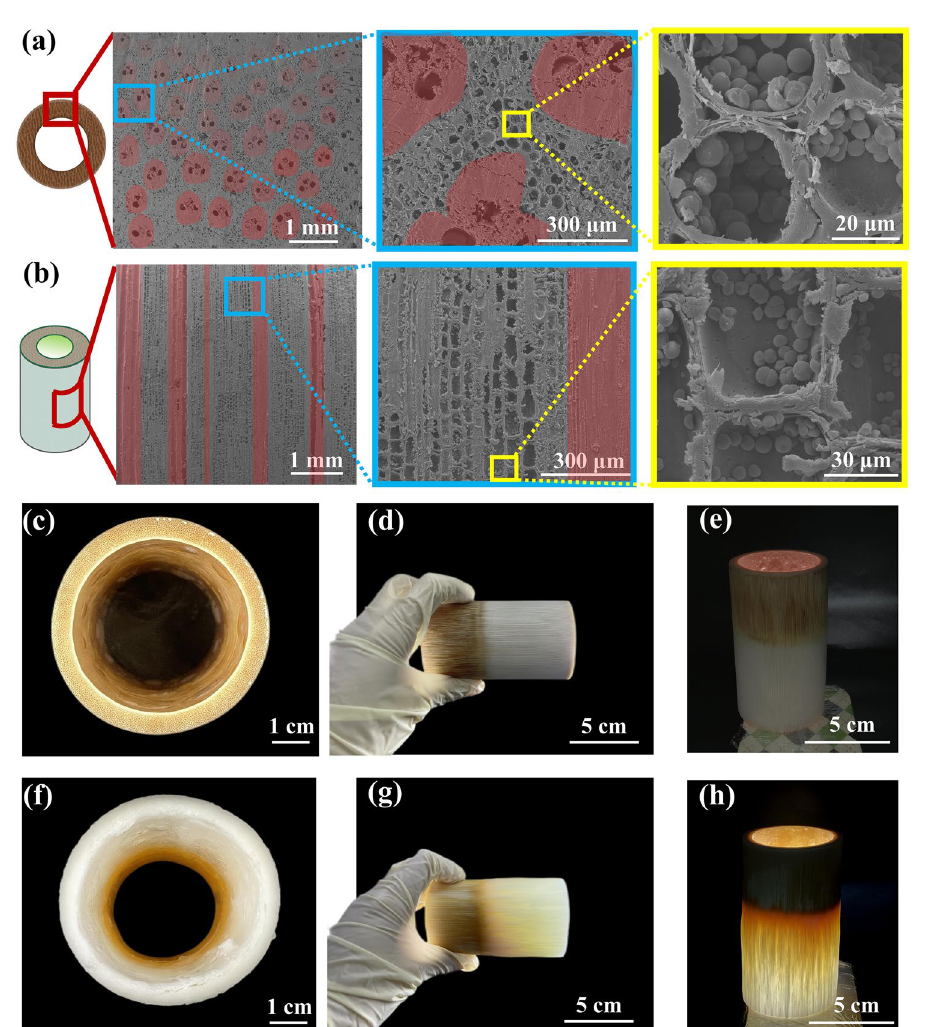
Fig. 2 a Cross-sectional SEM images of OB. b SEM images of the longitudinal section of OB. c Photograph of the cross section of S12. d Mac- roscopic view of S12. e Macroscopic view of S12 under the light. f Photograph of the cross section of H12. g Photograph of H12. h Photograph of H12 under the